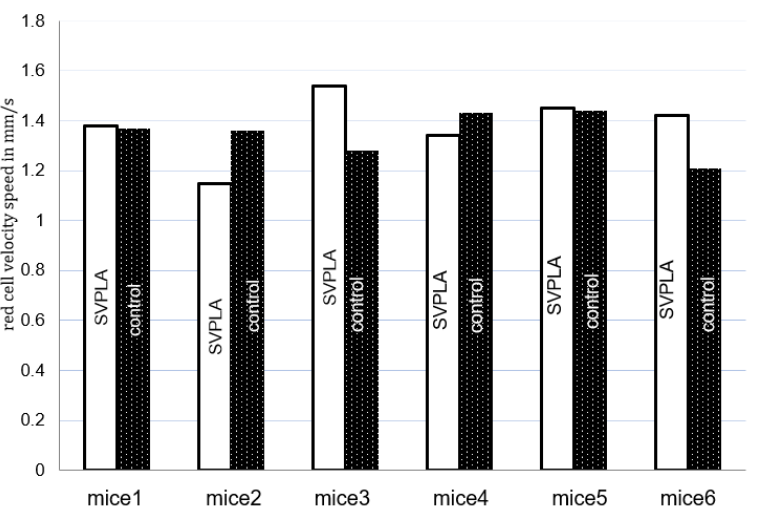
Figure 10. The velocity distribution of erythrocytes after administration of SVPLA microspheres vs. control. Animal model of microcirculation (mice).